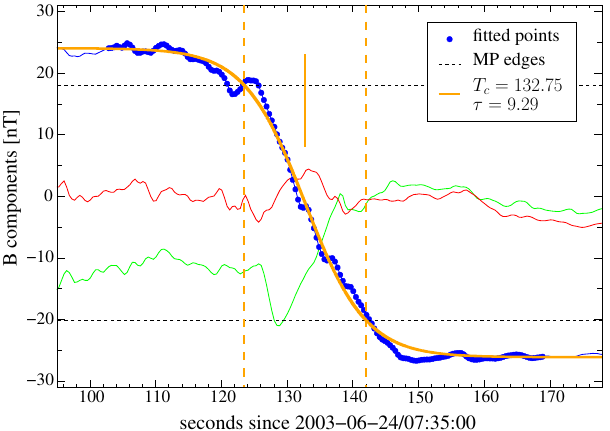
Fig. 5. C1 magnetic field components along the directions of minimum magnetic field variance (red trace), of maximum magnetic field variance (blue trace) and along h B i (green trace). The timing information, shown in the legend box, is obtained by fitting the points (in blue) corresponding to the maximum variance component with a hyperbolic tangent function, shown in orange. More details are provided in the text.